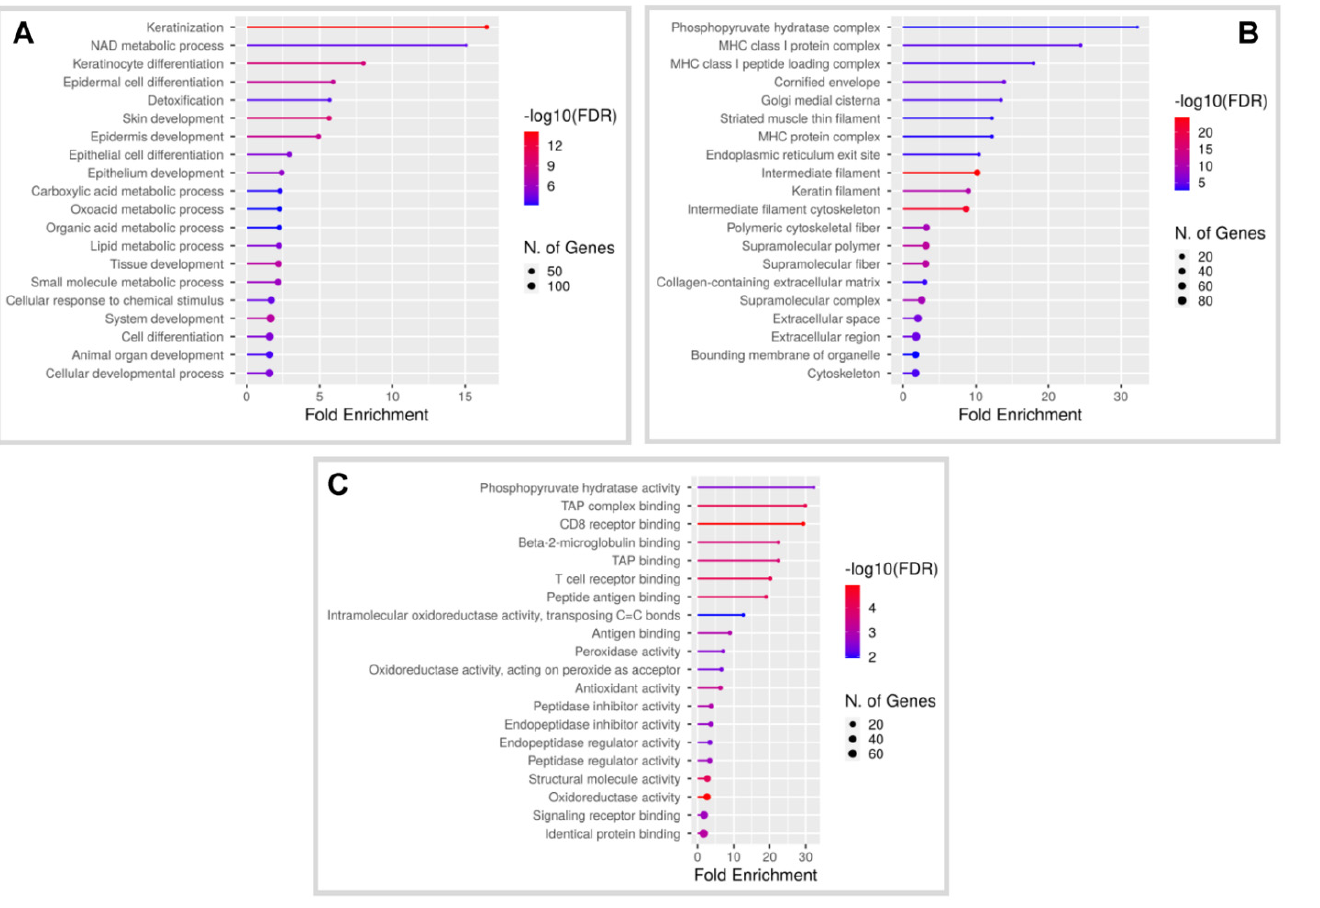
Figure 1. Gene ontology (GO) enrichment of DEGs in skin tumours of K14-HPV8-CER mice compared with non-lesional FVB/N wild-type skin. The GO categories ( A ) Biological process, ( B ) Cellular component and ( C ) Molecular function categories are shown (fold enrichment: high (red), low (blue)). The KEGG pathway analysis pointed to four upregulated and 10 downregulated pathways. The analysis for downregulated DEGs pointed towards an enrichment of genes associated with a staphylococcus aureus infection. Upregulated pathways were mainly associated with sphingolipid metabolism and the IL-17 signalling pathway (Figure 2). Next, RT-qPCR was performed to validate the differential expression of some DEGs. As shown in Figure 2D, mRNA levels of KLK6, LCN2 and FOSL1 were found to be significantly overexpressed in UV-induced skin tumours in K14-HPV8-CER mice compared to FVB/N wild-type skin, collected 24d after irradiation. These data significantly strengthen the robustness of the microarray